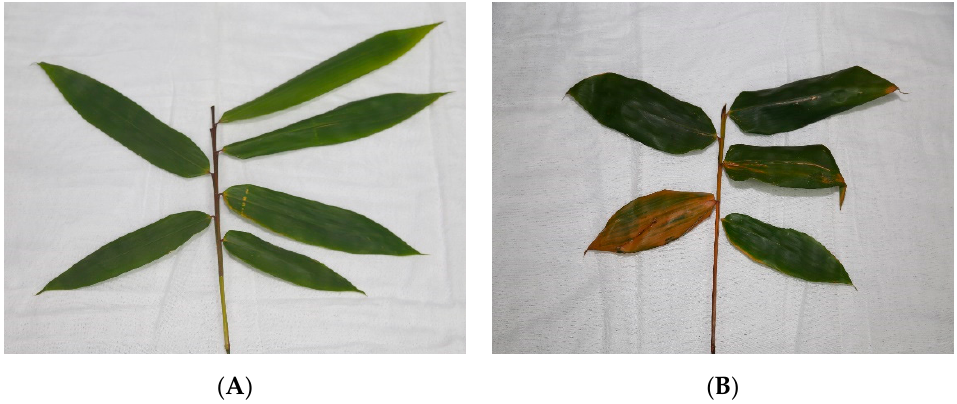
Figure 1. Photos of characteristic samples of B. pervariabilis × D. grandis after A. phaeospermum (AP)